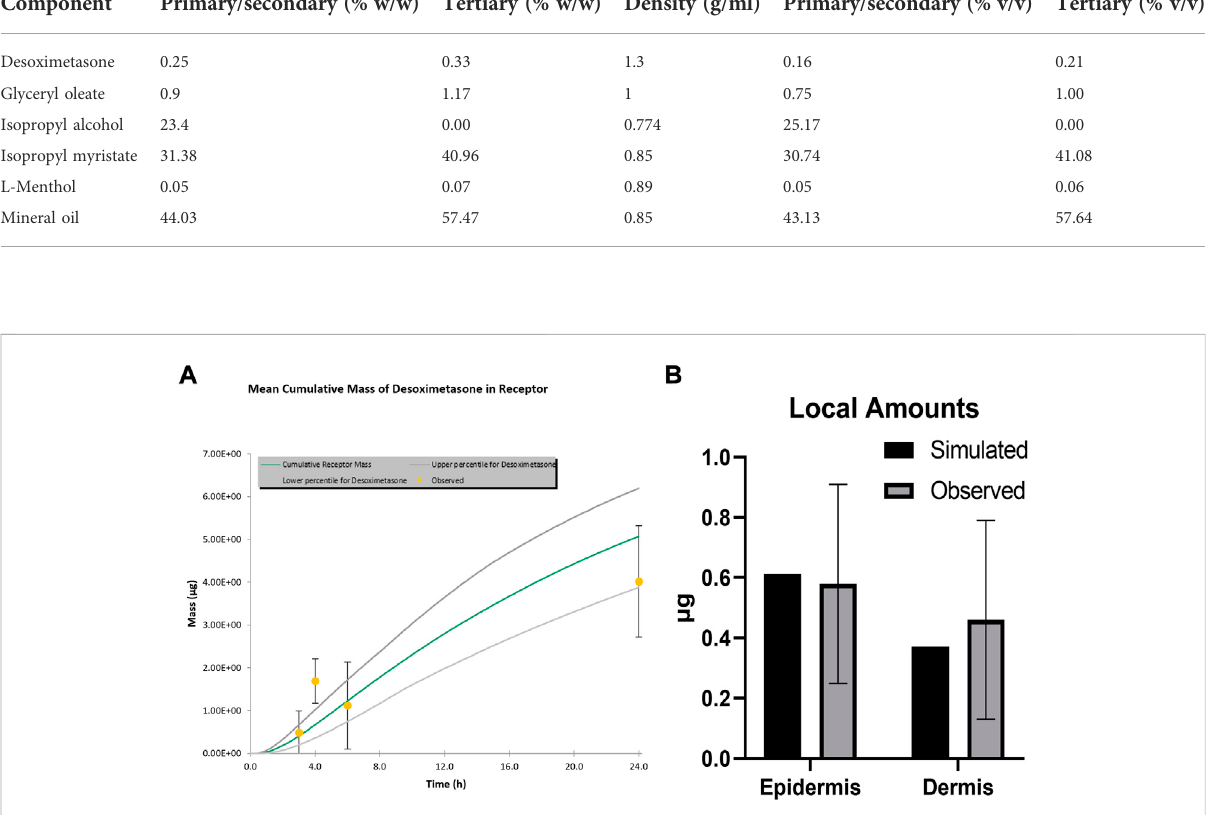
FIGURE 1 Simulated and observed IVPT results for Topicort Ⓡ Spray 0.25% (A) Receptor Pro fi le (B) Local